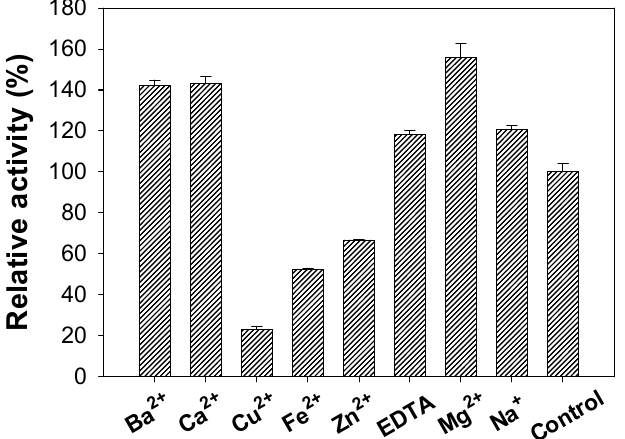
Figure 5. E ff ect of ion metals on the activity of TKU048 exochitinase. TKU048 exochitinase was pre-incubated with each of chemicals for 30 min. The activity of TKU048 exochitinase in the absence of treatment chemicals was used as a control to estimate relative activity (%).